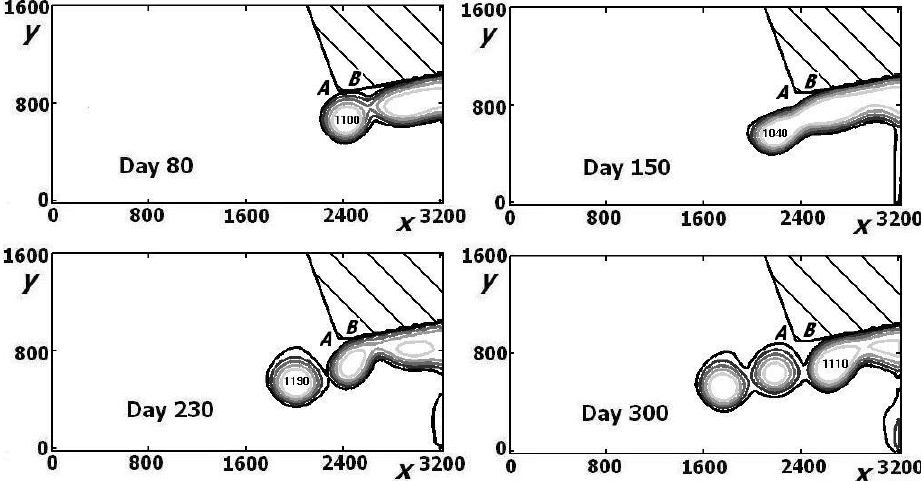
Fig. 10. Upper layer thicknesses for the case of a Concave II shoreline and a modest vorticity current that retroflects near the western termination of the slightly slanted coastline ( α = 0 . 4, h 0 = 0, ν = 1000m 2 s − 1 , and β = 6 × 10 − 11 m − 1 s − 1 ). This case is representative of NPR times. The strongly slanted section is moved out of the figure. Rings generation occurs more often than in Fig. 9, and the rings’ radii are